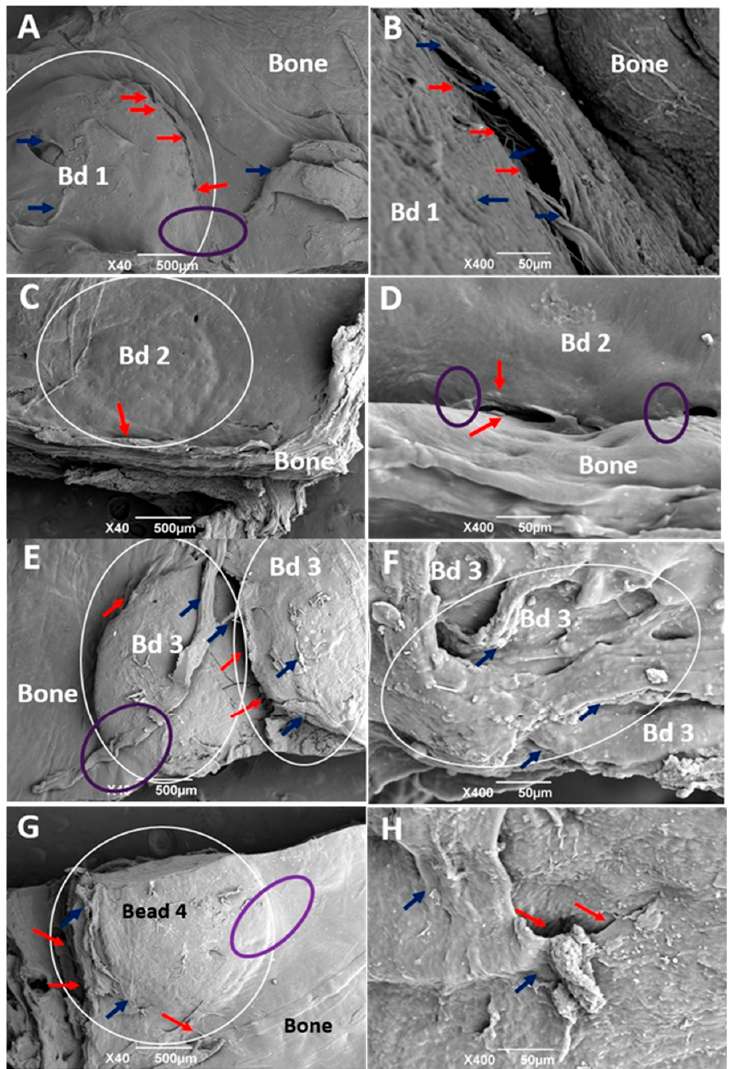
Figure 4. SEM analysis of the cranial implantation areas. ( A , B ): F1. ( C , D ): F2. ( E , F ): F3. ( G , H ): F4.. White circle: Bead implantation area. Red arrow: Interface area bead–bead, bead–bone. Blue arrow: Cover soft tissue. Purple oval: Incorporation area of the bead covering soft tissue with the bone covering soft tissue.